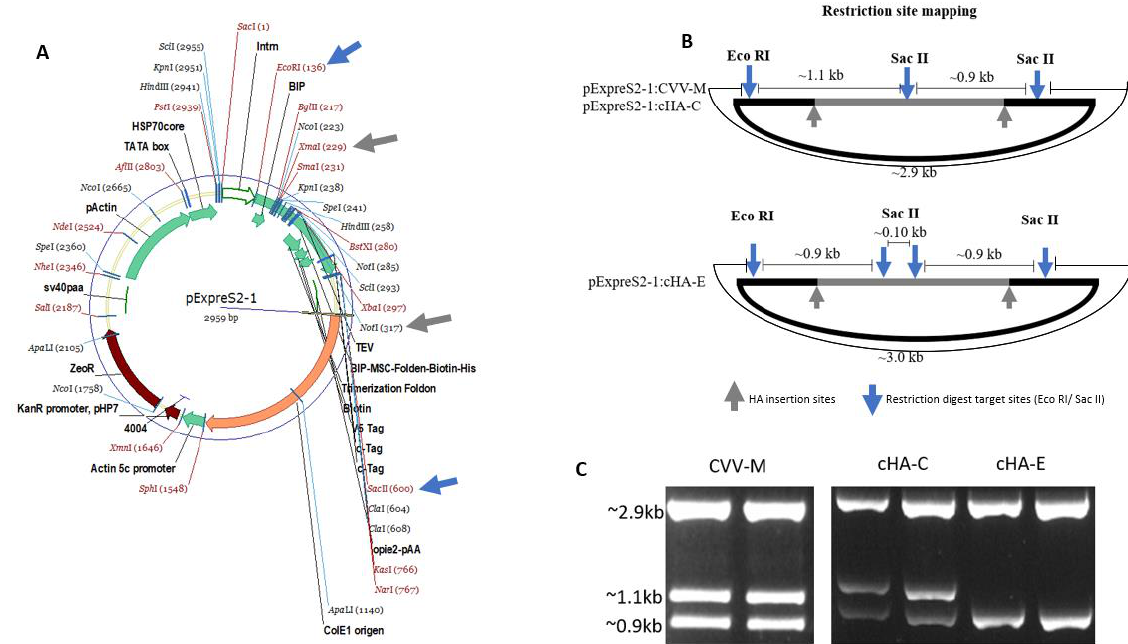
Figure 5. RFLP verification of the HA cloned onto the pExpreS2-1 plasmid. ( A ) Plasmid map detailing HA insertion sites between NotI and XmaI (grey arrows or grey outline B) and existing EcoRI and SacII restriction sites (blue arrows). ( B ) Representation of EcoRI and SacII restriction digest sites showing anticipated electrophoretic band patterns. ( C ) Restriction digest confirming expected electrophoretic band patterns: SacII cuts twice the plasmid with the CVV-M and cHA-C at similar sites and EcoRI cuts once, hence the three similar band patterns; cHA-E on the other hand, displays 3 SacII restriction sites, in addition to one EcoRI site, leaving two major bands. Primers were also designed to target the flanks of the HA insertion point on the plasmid. These primers as well as the cloned pExpreS2-1 plasmids were outsourced for sequencing by GeneArt Gene Synthesis (Thermo Fisher Scientific, UK). Returned sequences confirmed the HA orientation on the plasmid (not shown). Table 3. Turkey red blood cell haemagglutination assessment of cHAs and candidate vaccine vi- rus HAs.